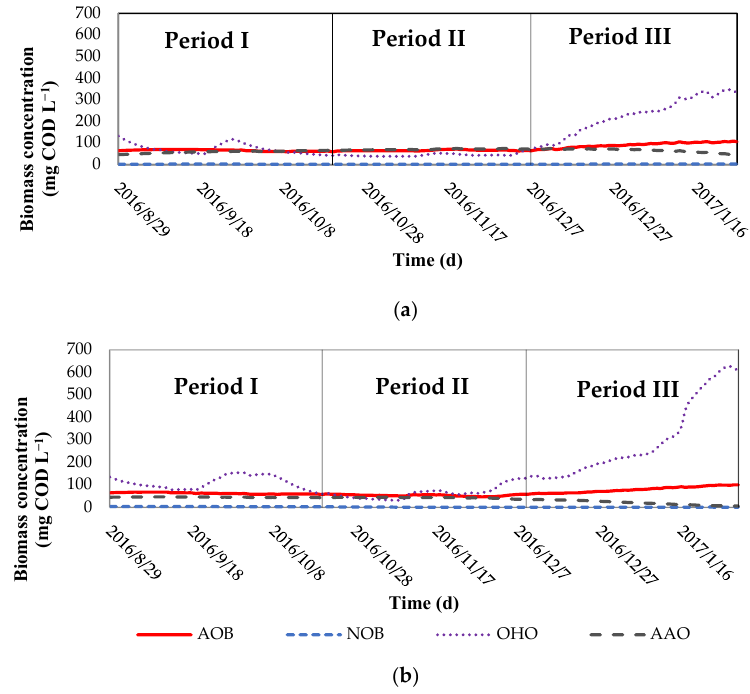
Figure 4. Simulated biomass trend in SBR A ( a ) and SBR B ( b ).